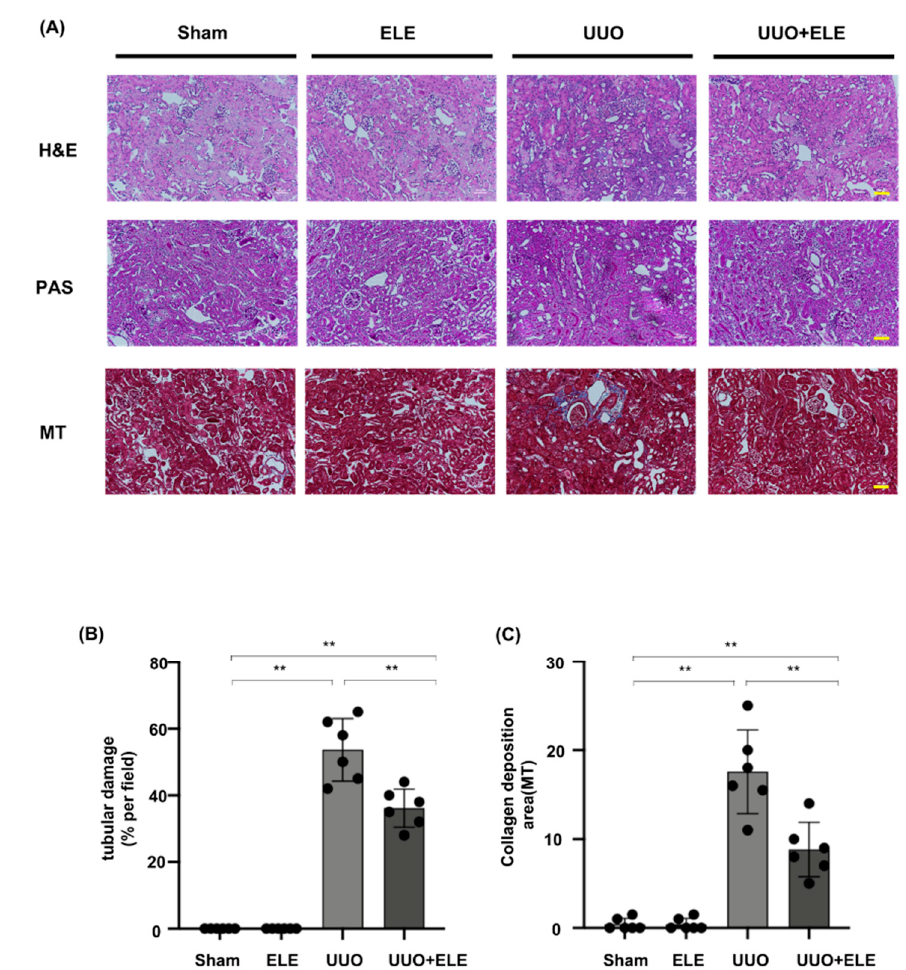
Figure 1. β -elemene ameliorated histopathological alterations in UUO mice. ( A ) Histological changes were assessed by H&E and PAS staining with typical interstitial tubular positive changes. Fibrosis was assessed by MT with typical interstitial fibers. Original magnification= × 20. Bar = 50 µ m. ( B ) Kruskal-Wallis test for tubular damage, n = 6. ** p < 0.01, ns: no significance. ( C ) Statistical significance was presented as the mean ± SD, n = 6. ** p < 0.01, ns: no significance. Mice in the ELE and UUO+ELE groups were treated intraperitoneally with β -elemene at a dose of 40 mg/kg/d for 7 days, 24 h before and after surgery. All mice had their kidneys harvested on day 7. H&E, hematoxylin and eosin; PAS, Periodic Acid-Schiff stain; MT, Masson’s trichrome stain; ELE, β -elemene; UUO, unilateral ureteral